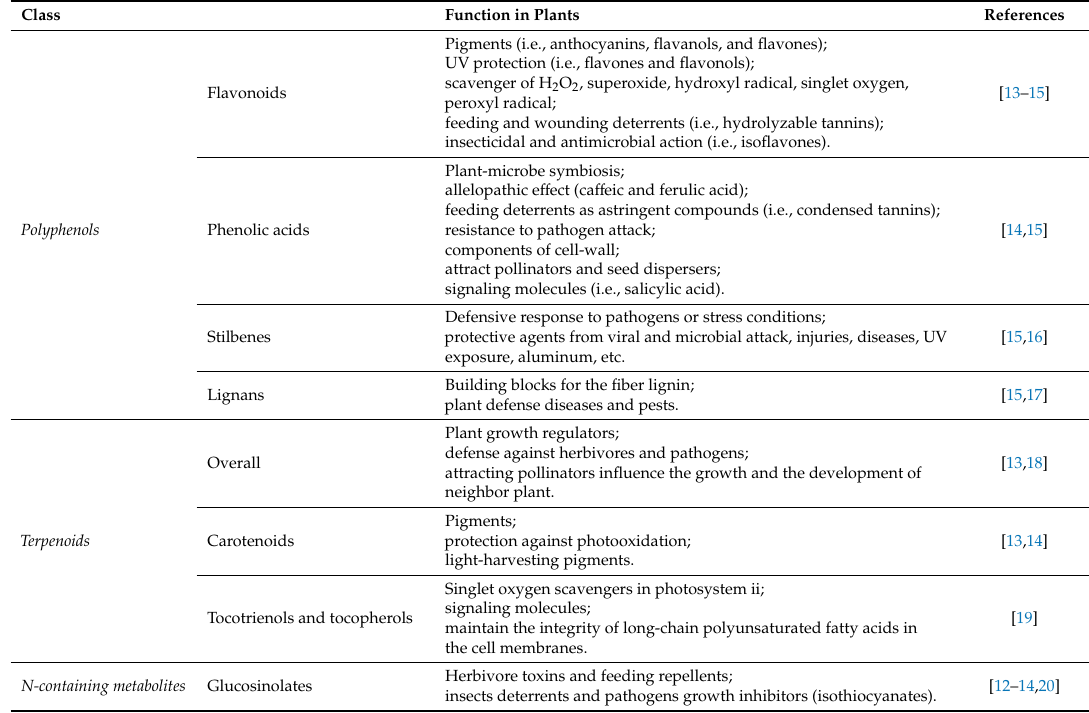
Table 1. Main functions recognized to the principal phytochemical classes and